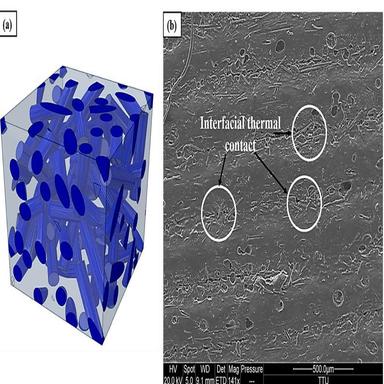
SEM images showing the thermal contact between the fibers.